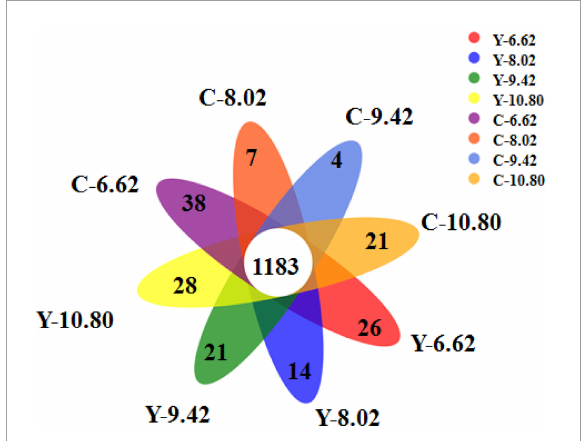
FIGURE1 Flower plot showing different and similar OTUs in yak (Y) and Qaidam cattle (C) offered low protein diets differing energy levels (MJ ME/kg